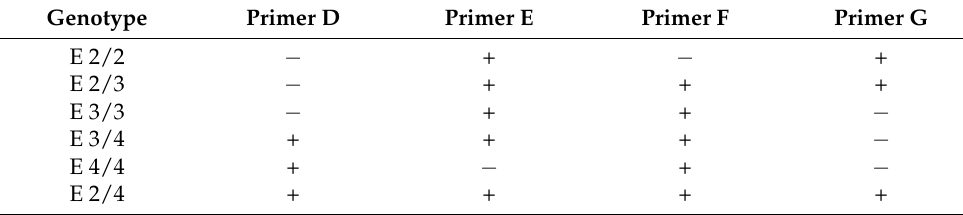
Table 7. The primer combination of every genotype. The E3/3 genotype yielding a 145 base pair product with primer E, indicating the presence of Cys 112, and a 277 base pair product with primer F indicating the presence of Arg 158. The heterozygote E3/4 produces appropriately sized products with primers E and F identifying the E3 allele, but also produces a 145 base pair product with primer D indicating Arg 112. Homozygous E4/4 subjects only react with primers D and F, marking the presence of Arg 112 and Arg 158, while E2/2 homozygotes only react with primers E and G, indicating Cys 112 and Cys